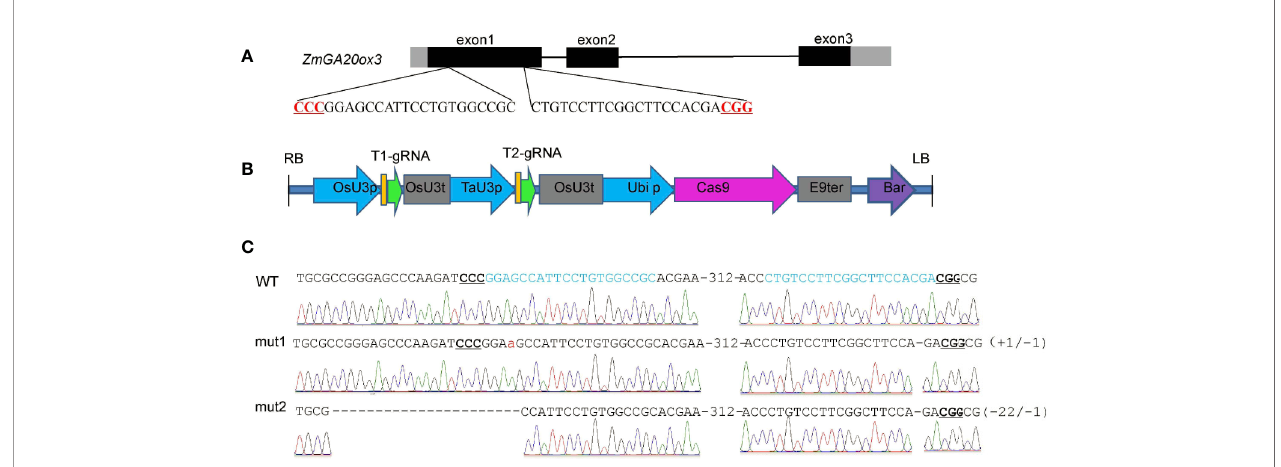
FIGURE 1 | CRISPR/Cas9-mediated mutations at ZmGA20ox3 target sites in plants. (A) Schematic illustration of the target sites. The black and gray boxes indicate the exons and UTRs, respectively, of the ZmGA20ox3 gene. The black DNA sequence is the target sequence. Nucleotides in red represent PAM sequences. PAM, protospacer-adjacent motif. (B) The T-DNA region of the pBUE411-2gR-GA plasmid. (C) Sequence peaks of wild-type and representative homozygous mutants at target sites. The red lowercase letter represents an adenine insertion in